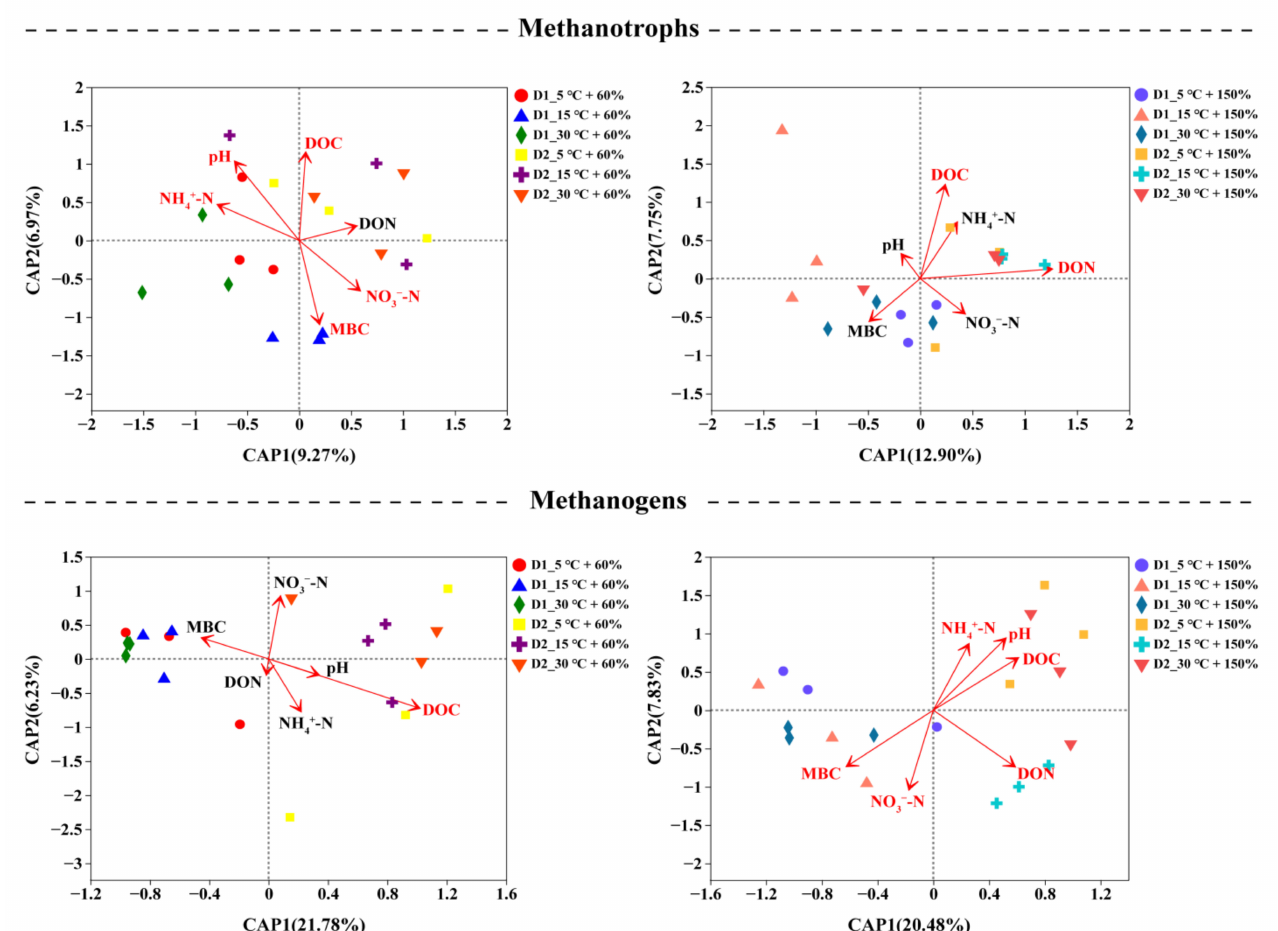
Figure 6. Distance-based redundancy analysis (db-RDA) of relationship between soil properties and methanotrophs (upper figures) and methanogens (lower figures) community composition. Samples from two soil depths: D1 (0–20 cm) and D2 (20–50 cm) were incubated at temperatures of 5, 15, and 30 ◦ C in combination with soil moisture states of 60% and 150% water-filled pore space. Red arrows indicate soil properties, and arrow lengths represent the degree of correlation of soil properties on microbial community composition. The angle of the arrows represents the direction of correlation (acute angles: positive correlation; obtuse angles: negative correlation). Red font indicates a significant effect of soil chemical properties on microbial communities. MBC: microbial biomass carbon; DOC: dissolved organic carbon; DON: dissolved organic nitrogen; NH 4 + -N: ammonium nitrogen; NO 3 − -N: nitrate